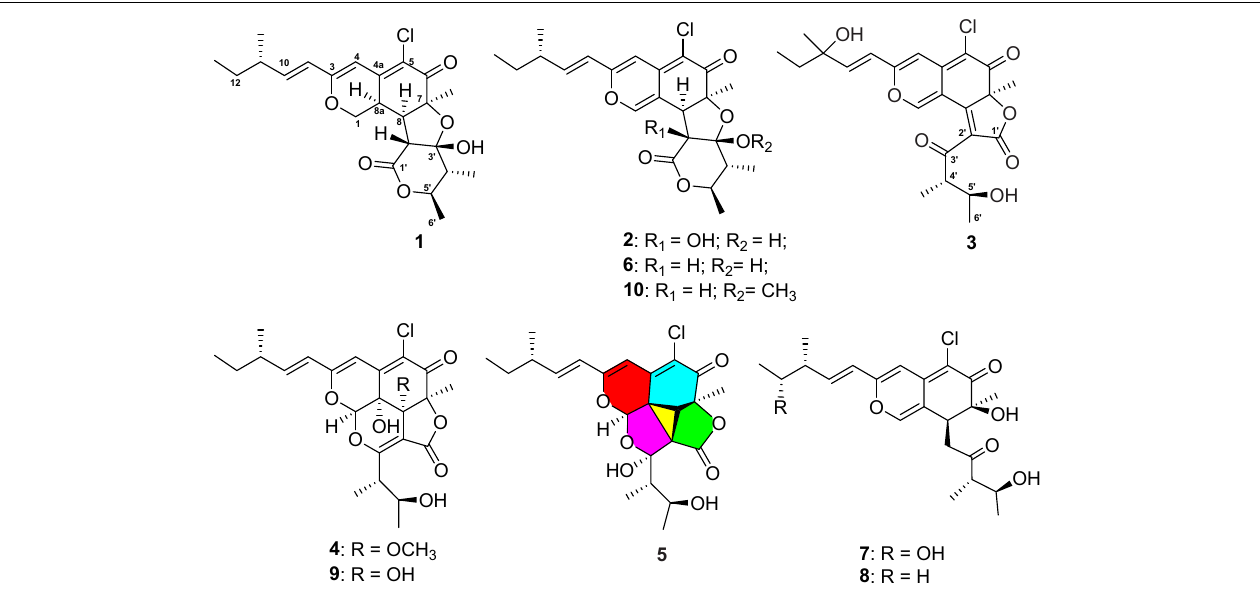
FIGURE 1 | Structures of compounds